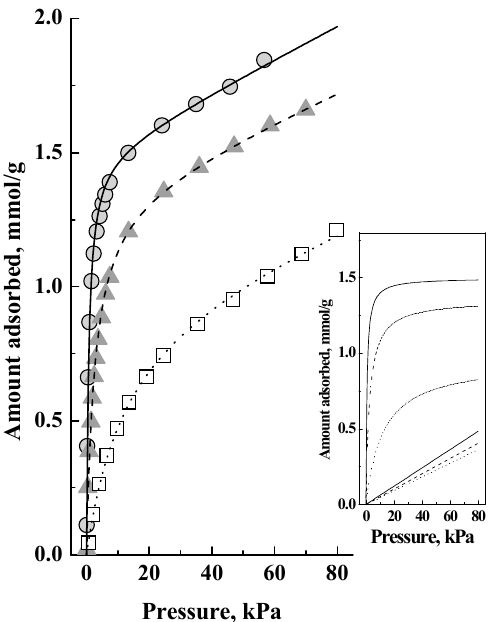
Figure 2. Adsorption isotherms of dimethyl ether on SAPO-34 zeolite at 25 °C ( ● ), 60 °C ( ▲ ) and 100 °C ( □ ). The lines show the best fit curves calculated as the sum of the component Langmuir and Henry isotherms shown in the inset.